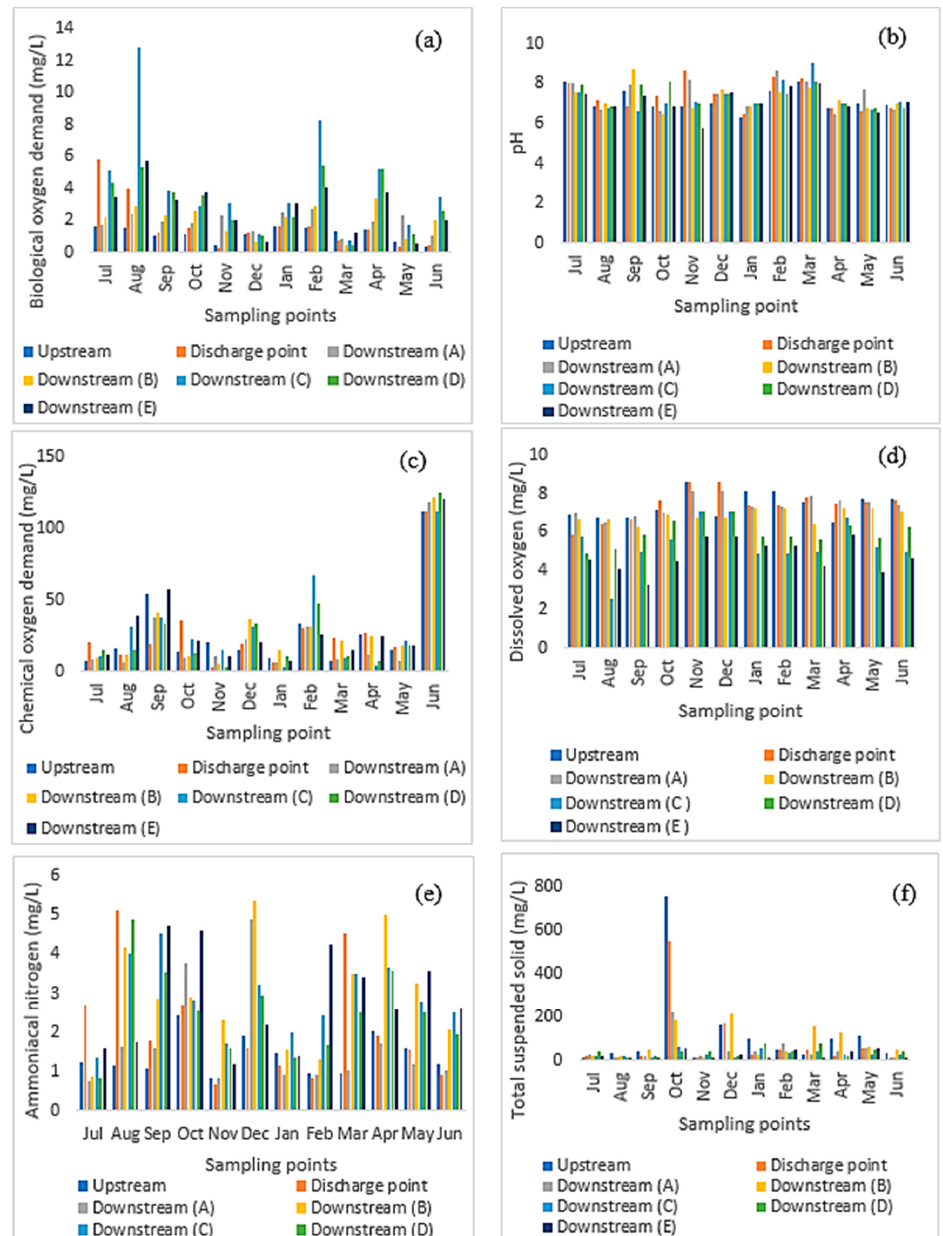
Figure 6. Water quality parameters. ( a ): BOD, ( b ): pH, ( c ): COD, ( d ): DO ( e ): AN, and ( f ): TSS at each point along the Johan River.